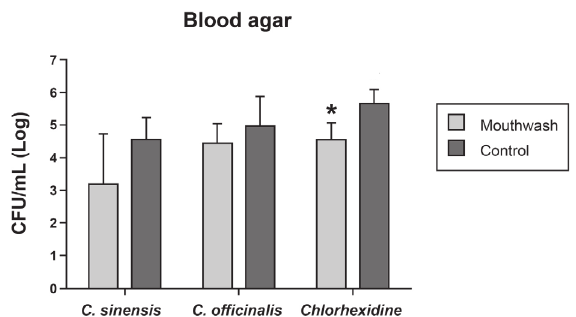
Figure 3- Mean number and standard deviation of Figure 2- Mean number and standard deviation of colony- colony-forming units (CFU)/mL (log ) of microorganisms 10 forming units (CFU)/mL (log ) of microorganisms isolated isolated from suture materials and grown on Sabouraud 10 from suture materials and grown on blood agar obtained agar obtained for the control groups and groups for the control groups and groups using Camellia sinensis , Calendula officinalis and chlorhexidine mouthwash and control groups of cholorhexidine (Student's t-test)